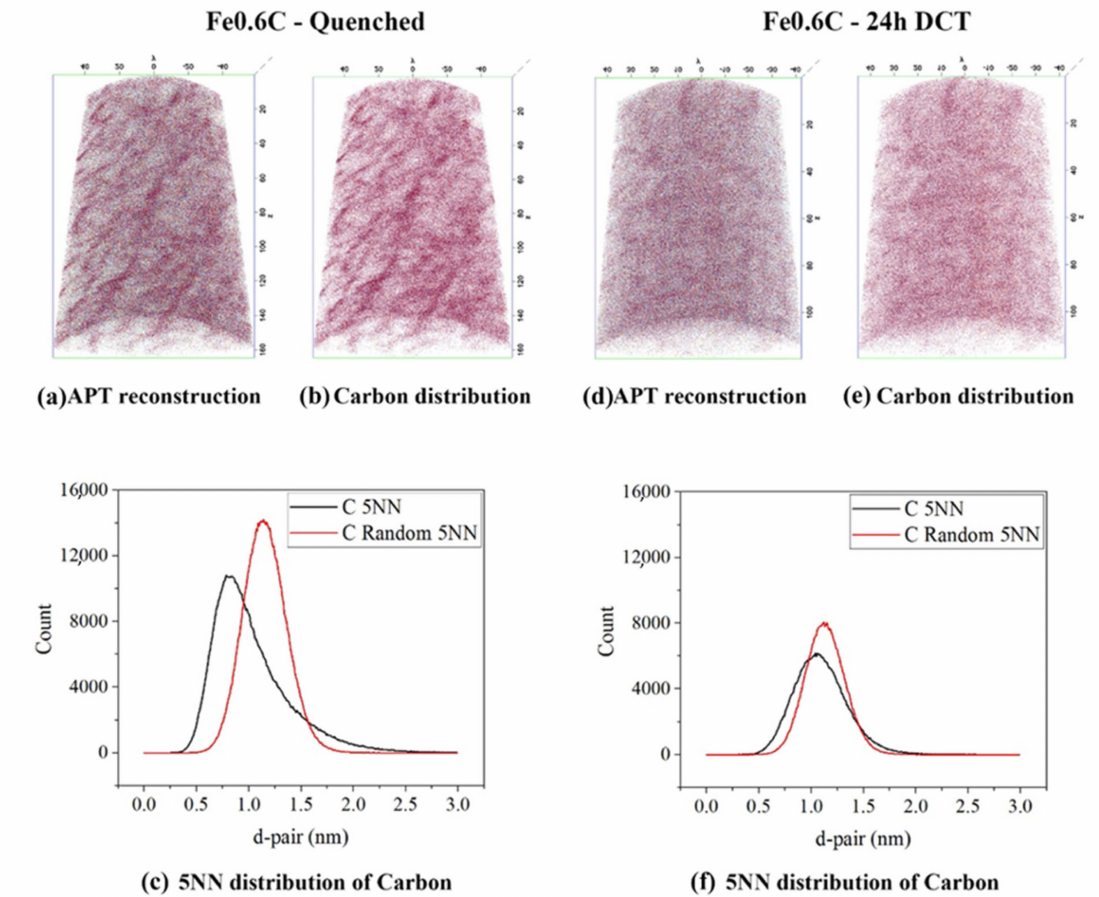
Figure 6. Atom probe tomography of Fe-0.6C alloy. All volumes were measured from atom probe tips produced from the same sample and show the inherent variability in solute distribution within martensitic structures. 5NN represents that the five nearest neighbors have been used for the data